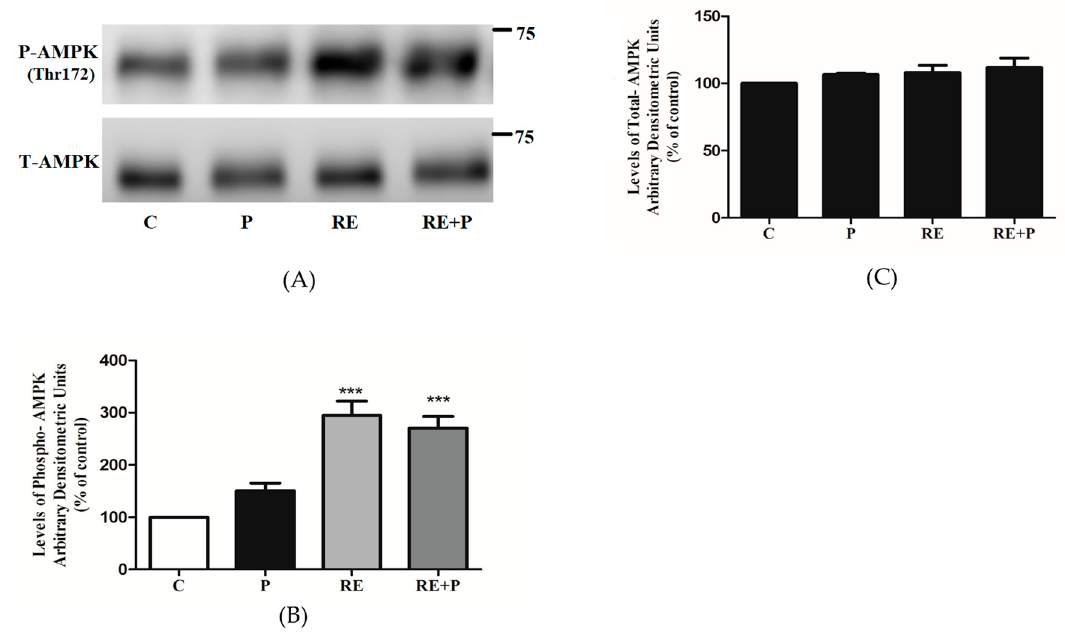
Figure 7. Effects of palmitate and RE on AMPK expression and phosphorylation. Fully differentiated myotubes were treated without (control, C) or with 0.2 mM palmitate (P) for 16 h in the absence or the presence of 5 µ g/mL RE. After treatment, the cells were lysed, and SDS-PAGE was performed, followed by immunoblotting with specific antibodies that recognize phosphorylated Thr172 or total AMPK. Representative immunoblots are shown ( A ). The densitometry of the bands was measured and expressed in arbitrary units ( B , C ). The data are the mean ± SE of three separate experiments (*** p < 0.001 vs. control).